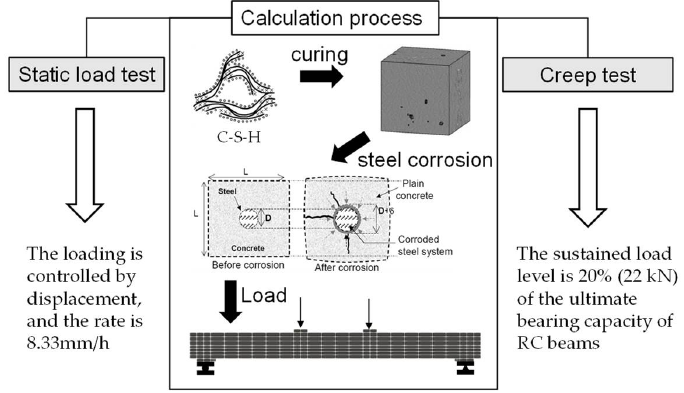
Figure 5. Calculation process of static load test and creep test.